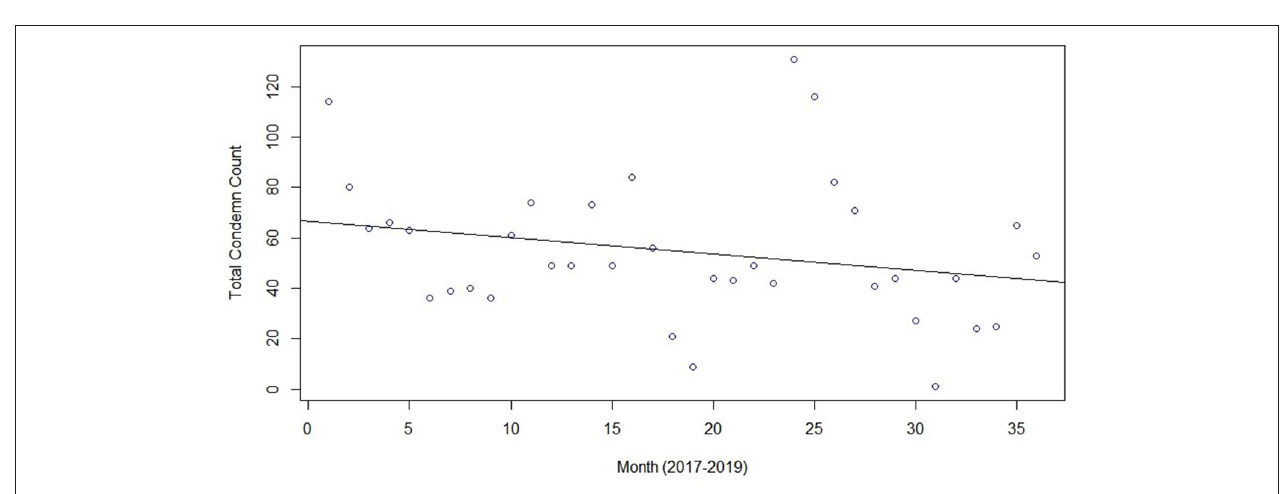
FIGURE 3 | Time series of monthly total slaughter counts with trend line, 2017–2019.